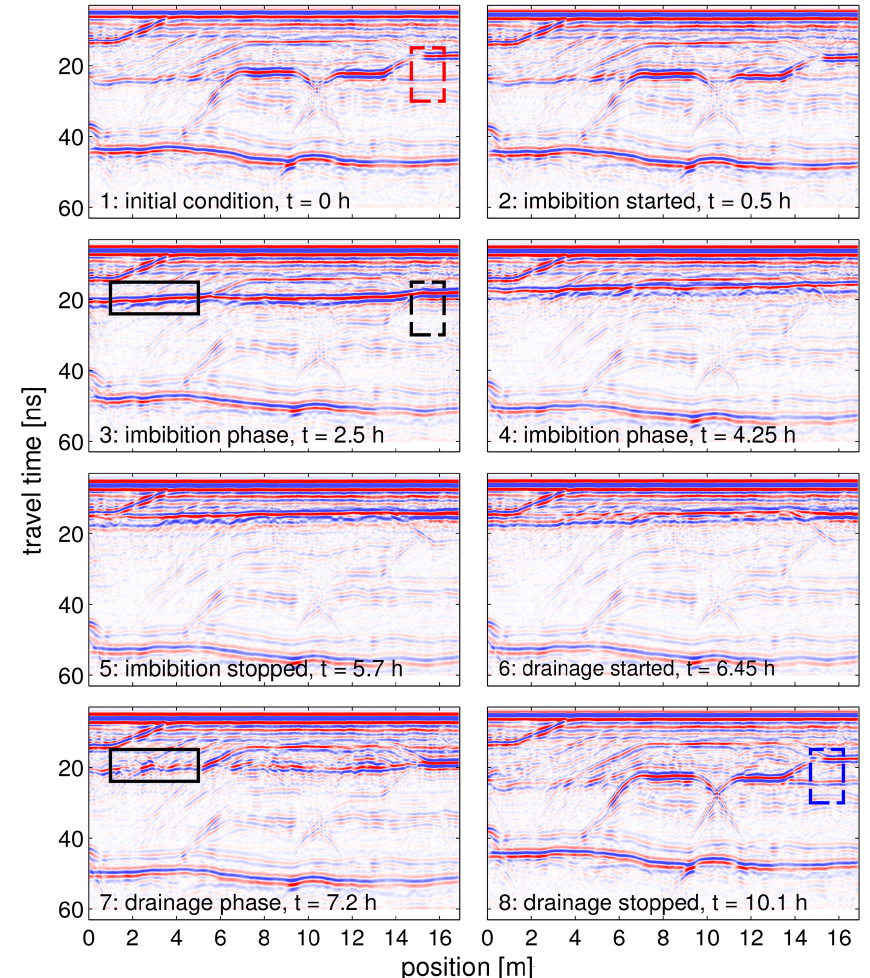
Figure 6. Common offset radargrams showing the hydraulic state during experiment 1 (imbibition/relaxation/drainage) at several charac- teristic times. The solid black rectangles in radargrams 3 and 7 mark the CFR at approximately the same position during imbibition and drainage, respectively. The dashed rectangles in radargrams 1, 3 and 8 denote the regions over which the traces shown in Fig. 7 are